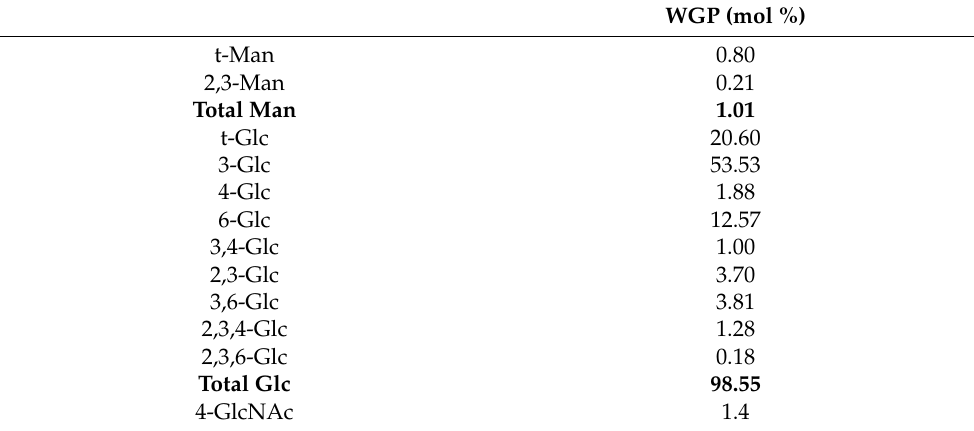
Table 1. Characterization of soluble WGP. Neutral sugar analysis of soluble WGP. Carbohydrate com- position of ( β 1,3)-Glucan (WGP) was determined by GC-FID and quantified using 2-deoxyglucose as internal standard. Mean results are presented in molecular percentage (mol %) and mass concentra- tion (mg/g). Each condition was set in triplicate. WGP mol % C (mg/g) Glucose 93.35 607.91 Mannose 0.58 Arabinose 0.07 Table 2. Characterization of soluble WGP. Glycosidic linkage composition (molecular percentage) of soluble WGP. The glycosidic-linkage composition of soluble WGP was determined by GC-MS of par- tially methylated alditol acetates. Man—Mannose; Glc—Glucose; GlcNAc— N —Acetylglucosamine Each condition was set in triplicate. WGP (mol